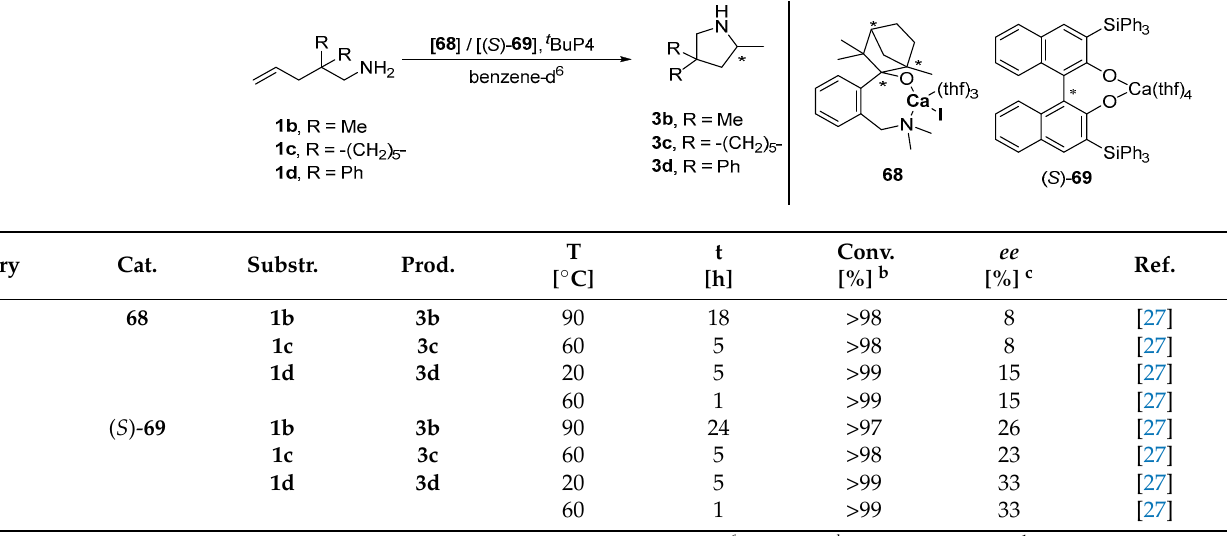
Figure 4. Catalytic cycle of the intramolecular hydroamination of aminoalkenes using CaI 2 as catalyst and t Bu P4 as external base [27]. Table 18. Catalytic asymmetric intermolecular hydroamination of aminoalkenes 1b – d using the chiral calcium catalysts 68 and ( S )- 69 a .